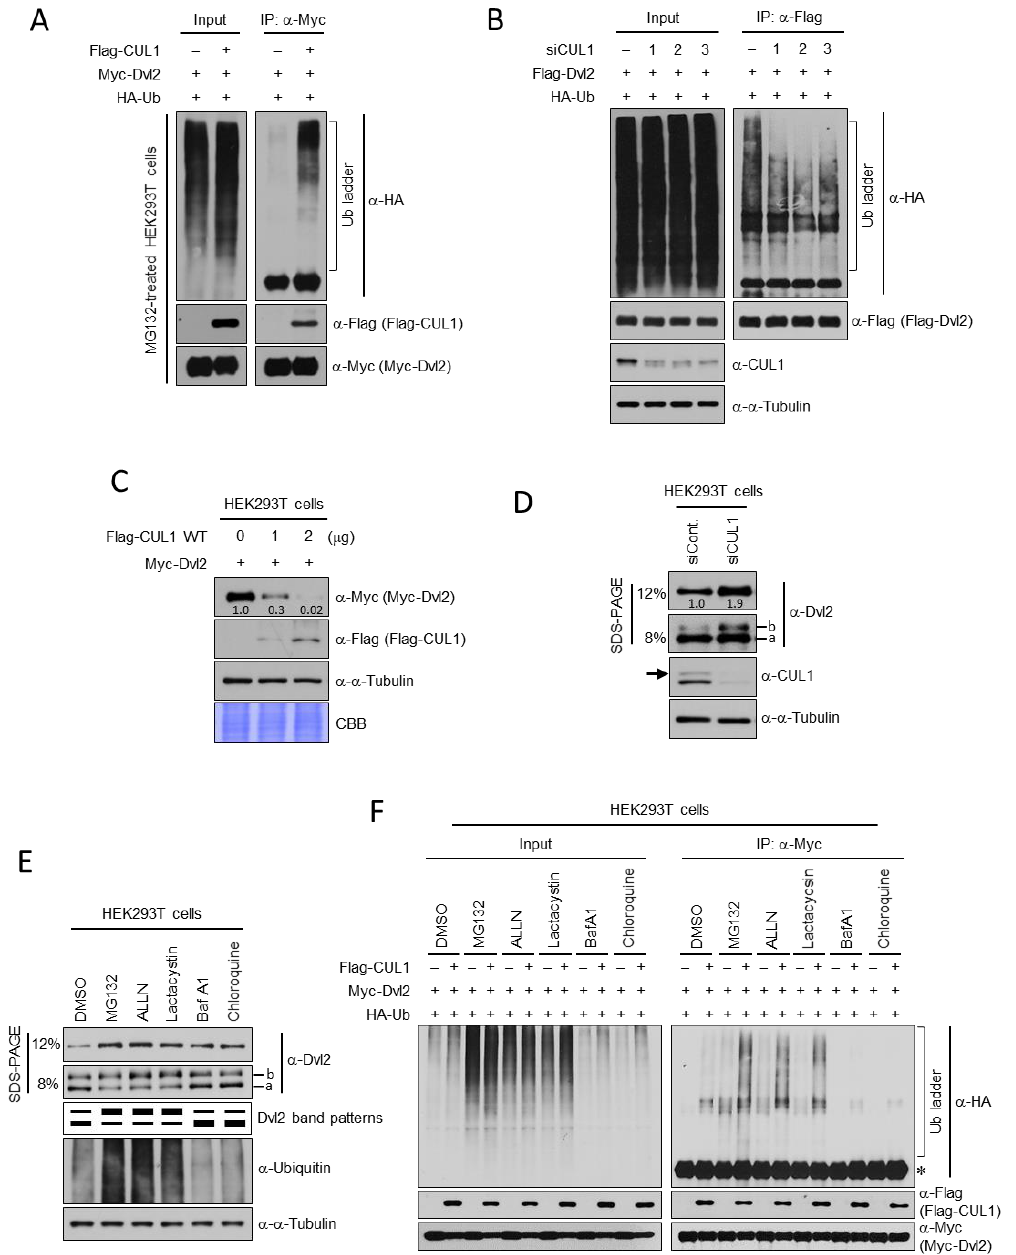
Figure 2. CUL1 mediates proteasome-dependent Dvl2 degradation. ( A ) HEK293T cells cotransfected with pFlag-CUL1 WT , pMyc-Dvl2 , and pHA-ubiquitin (Ub) were treated with 10 µ M MG132 for 3 h before cell harvest. Total cell lysates were subjected to IP with an anti-Myc antibody. The resulting immunoprecipitates were separated using 6% SDS-PAGE and immunoblotted with the indicated antibodies. ( B ) HEK293T cells were transfected with either control siRNA (-) or CUL1 siRNA (three different siRNA sequences referred to as 1, 2, or 3). After 24 h siRNA transfection, cells were then cotransfected with pFlag-Dvl2 and pHA-Ub . The resulting cell lysates were subjected to IP with an anti-Flag-antibody, and the immunoprecipitated beads were separated in 6% SDS-PAGE followed by immunoblotting analysis with the indicated antibodies. ( C ) HEK293T cells cotransfected with pFlag-CUL1 WT and pMyc-Dvl2 were subjected to immunoblotting analysis with the indicated antibodies. To monitor the effect of CUL1 on Dvl2 degradation, three different amounts of pFlag-CUL1 WT plasmids (0, 1, or 2 µ g) were transfected to cells; 0 µ g represents empty vector transfection. The band intensities of Myc-Dvl2 were measured using ImageJ and normalized to α -tubulin, and the relative values are marked below the bands. A constant amount of total DNA was transfected into the cells. ( D ) Total cell lysates from HEK293T cells transfected with either control (siCont.) or CUL1 siRNA (siCUL1) for 24 h were subjected to immunoblotting analysis with the